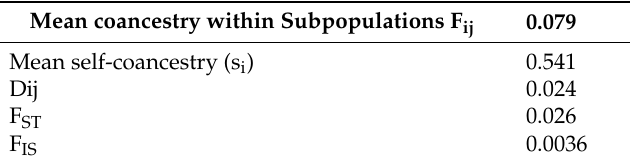
Table 5. Genetic similarities within the population.